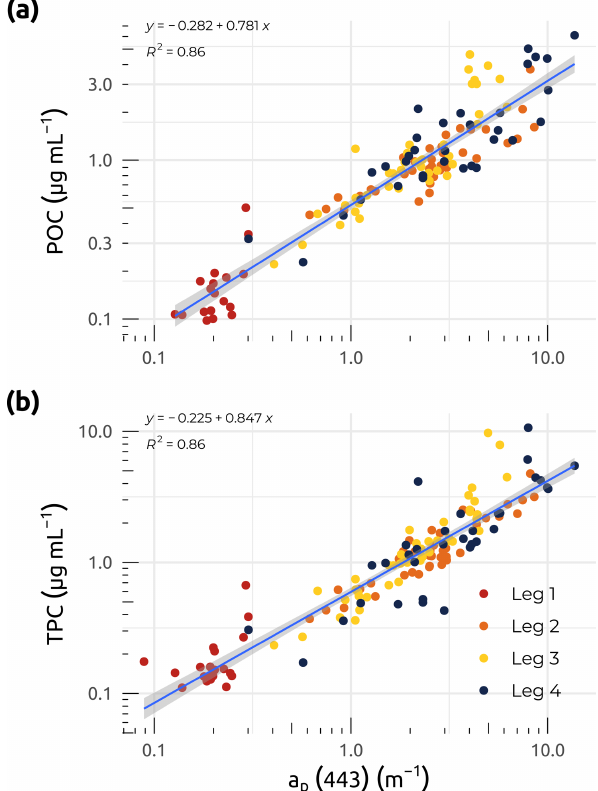
Figure 7. Linear regressions between particle absorption ( a p ( λ )) at 443nm and (a) particulate organic carbon (POC). (b) Total par- ticulate carbon (TPC) for the four WP4 Nunataryuk expeditions (Legs 1, 2, 3, and 4) in 2019. Equations and coefficients of deter- mination ( R 2 ) are shown. The blue lines represent the linear regres- sions, whereas the shaded gray areas show the standard error around the regression lines. Note that the data are plotted on a log